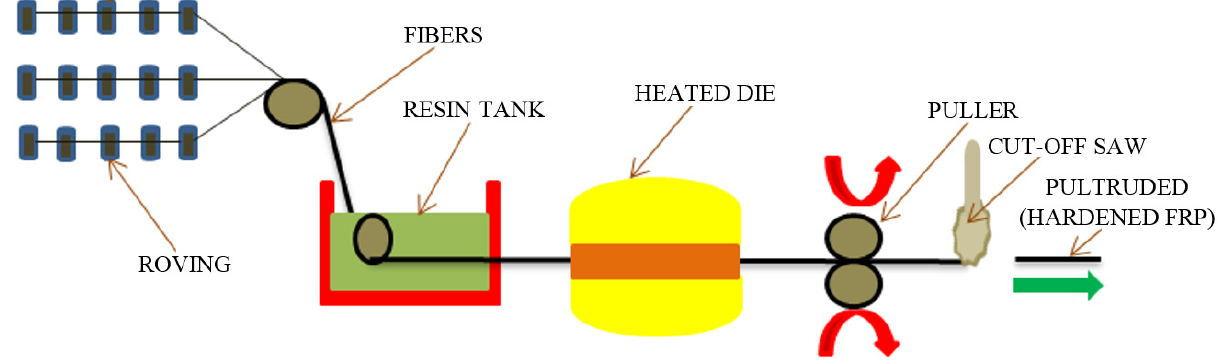
Figure 13. Schematic of the pultrusion process for the fabrication of FRP composites.